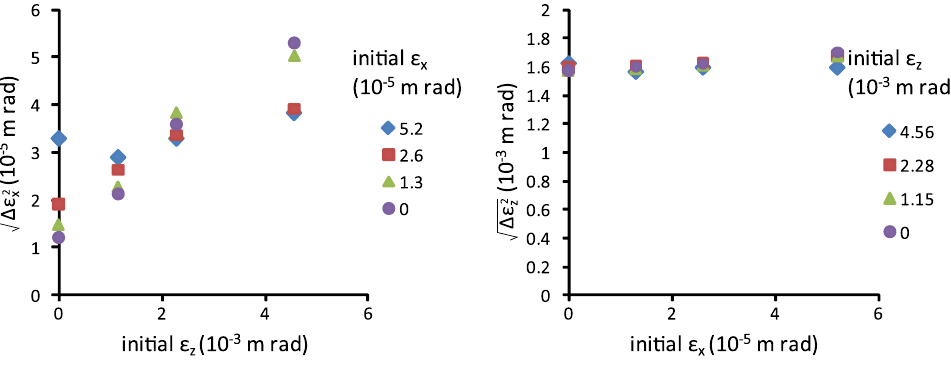
FIG. 8. Square root of (cid:1) (cid:1) 2